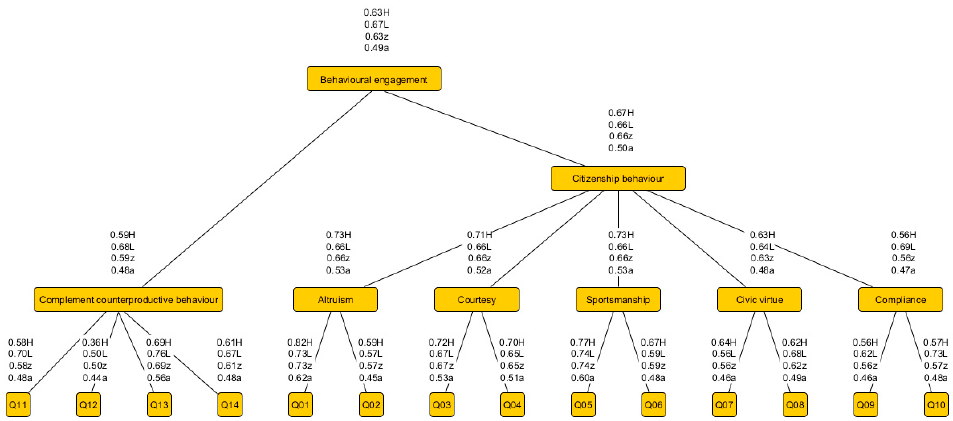
Figure 9. Complex fuzzy signature containing the calculated similarity measures of Hungarian and Lithuanian answers. Denotations: H is average of the Hungarian membership degrees, L is the average of the Lithuanian ones, z is the similarity measure calculated by Sim Z , and a is the similarity measure obtained by Sim Alg .